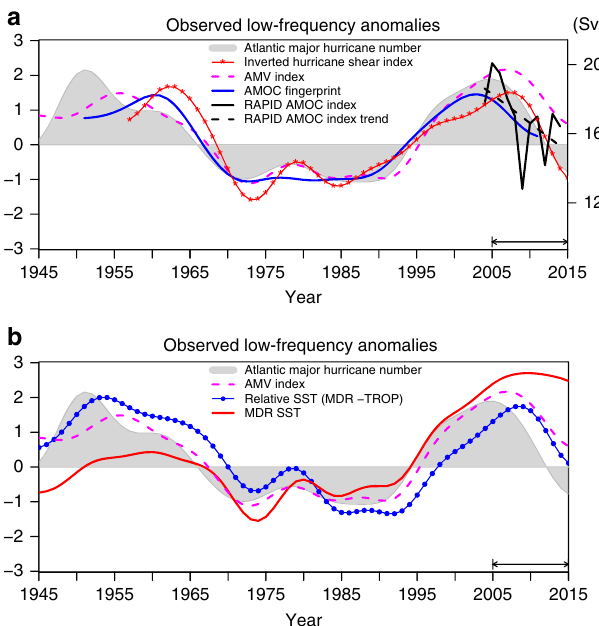
Fig. 2 Observed low frequency anomalies in Atlantic major hurricane frequency and associated climate variables. a Coherent variations are shown for Atlantic major hurricane frequency (grey shading), Inverted Hurricane Shear Index during the Atlantic hurricane season (JJASON) (solid red with stars), Atlantic Multidecadal Variability (AMV) Index (dashed magenta) and Atlantic Meridional Overturning Circulation (AMOC) Fingerprint (solid blue). The AMOC Fingerprint is shifted backward by 4 years to represent the AMOC anomalies at mid-high latitudes. Also shown are the un fi ltered annual mean RAPID AMOC Index at 26°N for 2004 – 2014 (solid black line) and its linear trend (dashed black line) with a unit of Sverdrup (Sv, right y -axis) ( b ) Variations of Atlantic major hurricane frequency (grey shading) and AMV index (dashed magenta) are compared with the main development region (MDR: 80°W – 20°W, 10°N – 20°N) averaged SST anomalies (solid red) and relative SST (solid blue with dots) during the Atlantic hurricane season (JJASON). The relative SST is de fi ned as the difference between MDR SST anomalies and tropical (TROP: 30°S-30°N) mean SST anomalies. All time series are 10-year low-pass fi ltered and normalized by their own standard deviation over the period 1957 – 2005. The key focus period (2005 – 2015) is highlighted by the line segment/arrows on plot